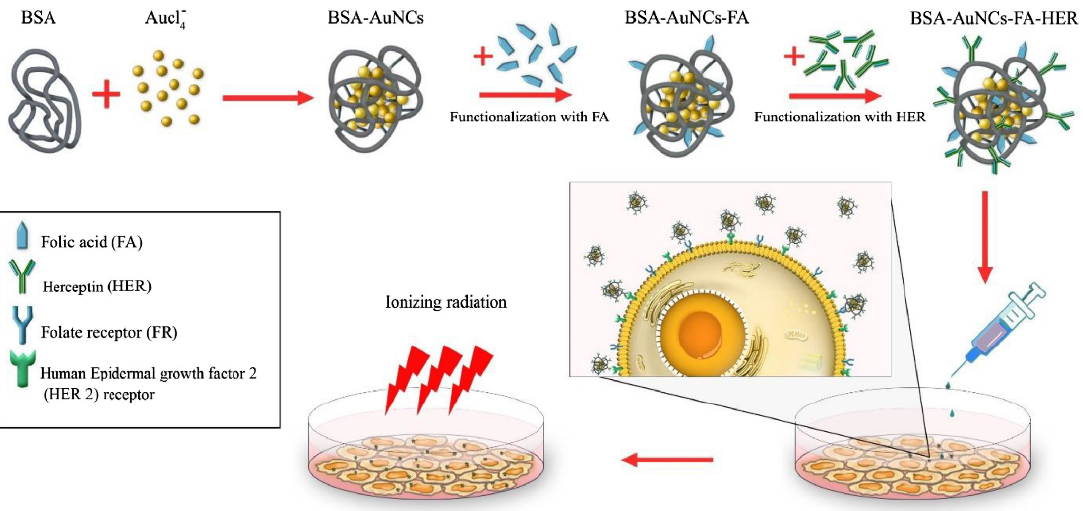
Figure 8. Schematic illustration of the functionalization process of bovine serum albumin (BSA) gold nanoclusters (AuNCs) with folic acid and Herceptin and the mechanism of cellular internalization by binding with folate and human epidermal growth factor 2 receptors on the surface of SK-BR3 cells. Reproduced from European Journal of Pharmaceutical Sciences 2020 , 153 , 105487. [179] Copyright Elsevier